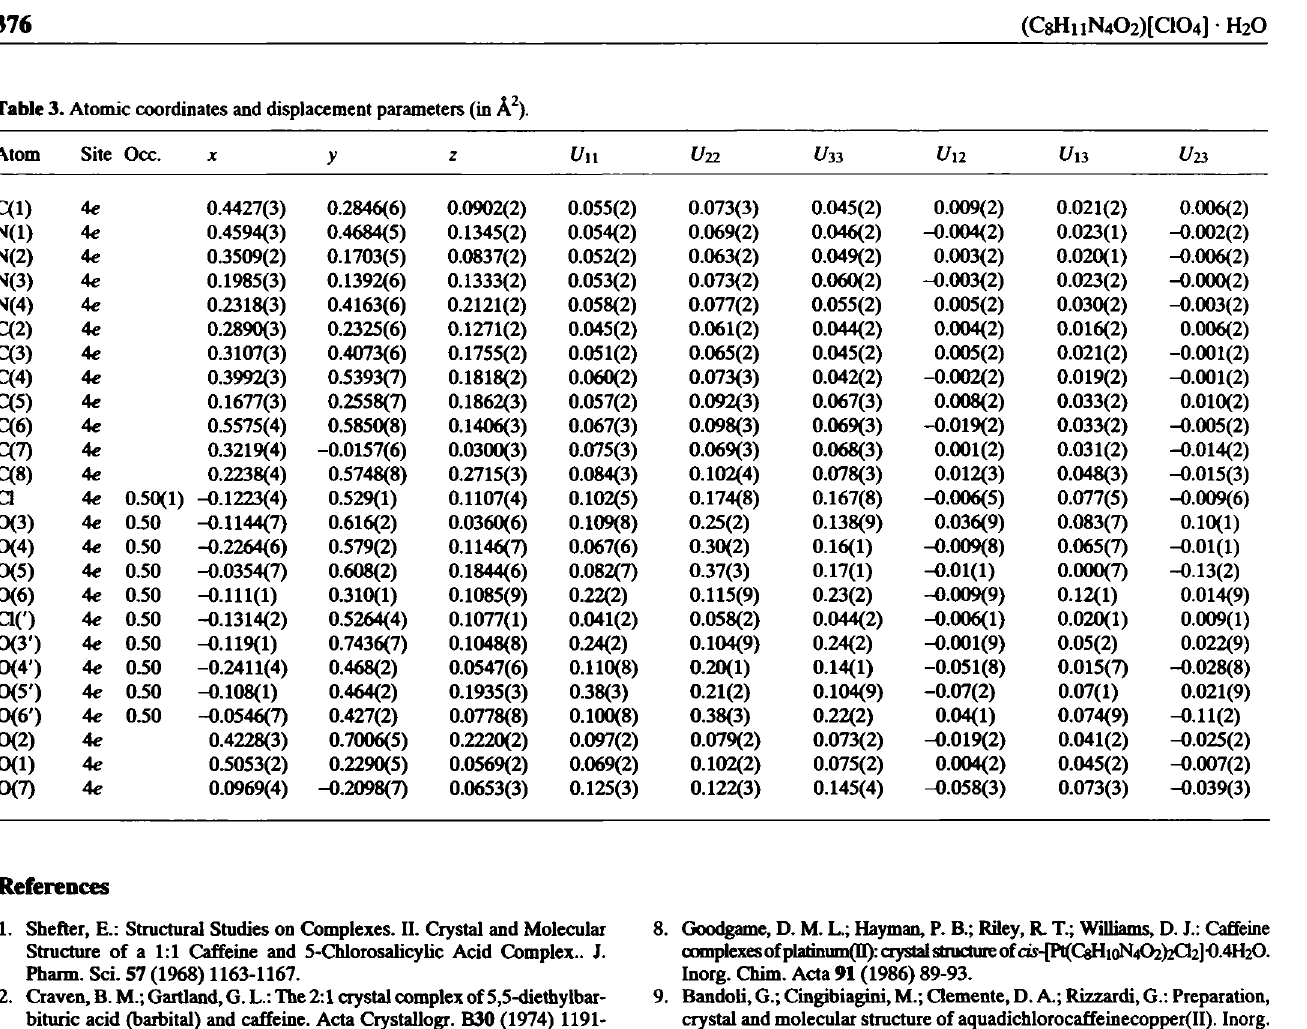
Table 3. Atomic coordinates and displacement parameters (in Ä 2